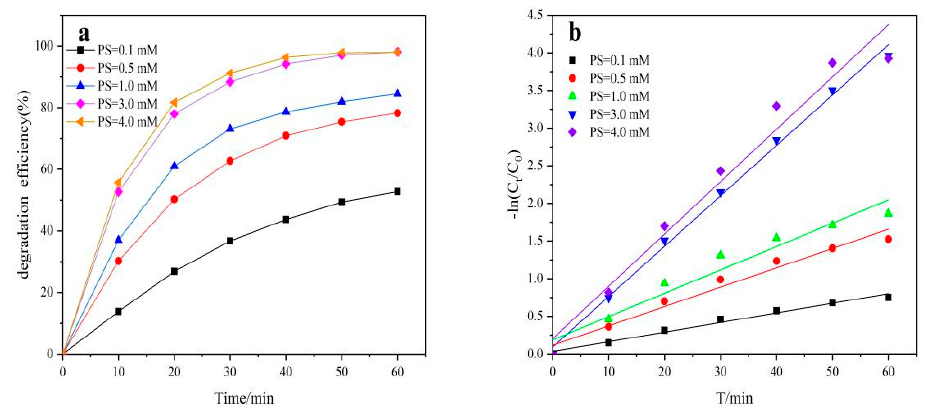
Figure 6. E ff ect of PS concentration on degradation e ffi ciency of NOR ( a ) and the corresponding pseudo Figure 6. Effect of PS concentration on degradation efficiency of NOR ( a ) and the corresponding first-order kinetics fitting ( b ). Experimental conditions: [NOR] = 10 mg / L, pH = 3, and electrolyte: pseudo first-order kinetics fitting ( b ). Experimental conditions: [NOR] = 10 mg/L, pH = 3, and 0.1 M Na 2 SO 4 electrolyte: 0.1 M Na 2 SO 4 . Table 3. The kinetic parameters of NOR degradation at different PS concentrations.